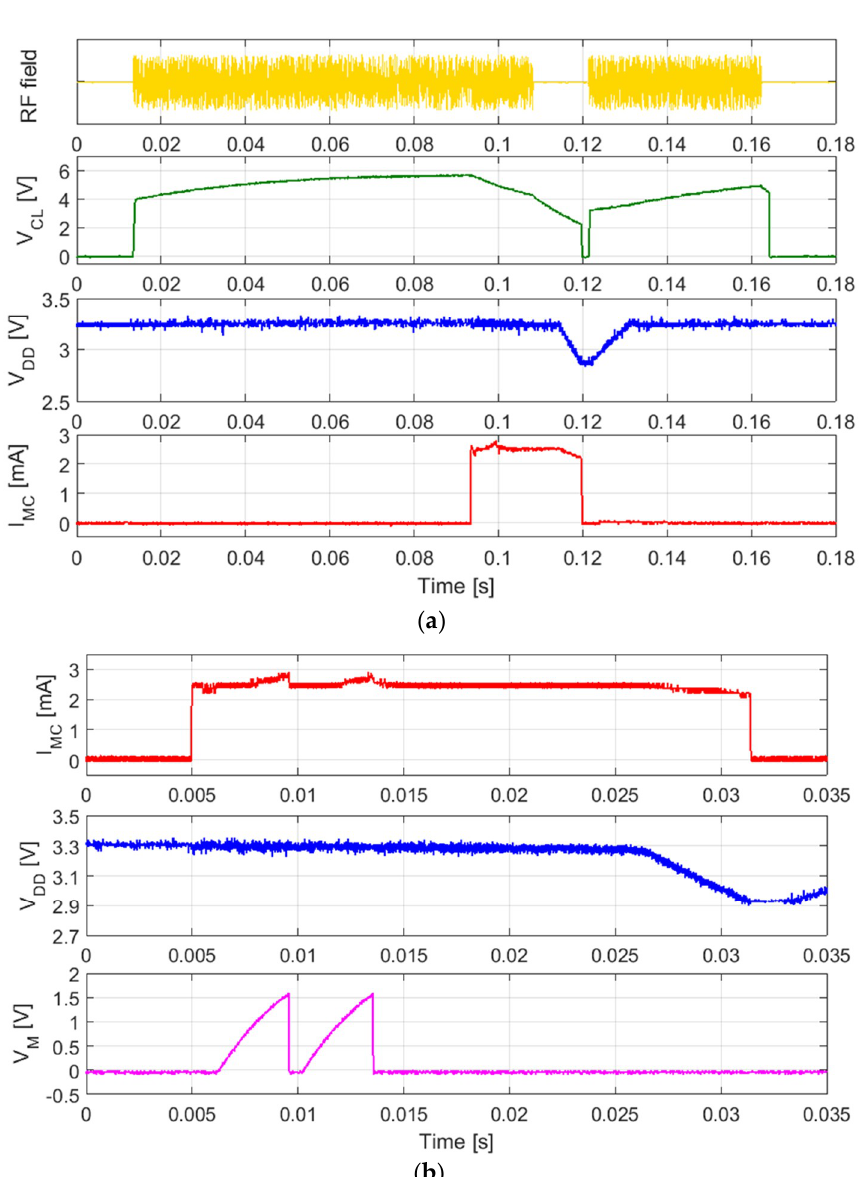
Figure 7. ( a ) RF field and V CL , V DD , I MC signals during a single measurement cycle; ( b ) detailed view of I MC , V DD and V M during the measurement.